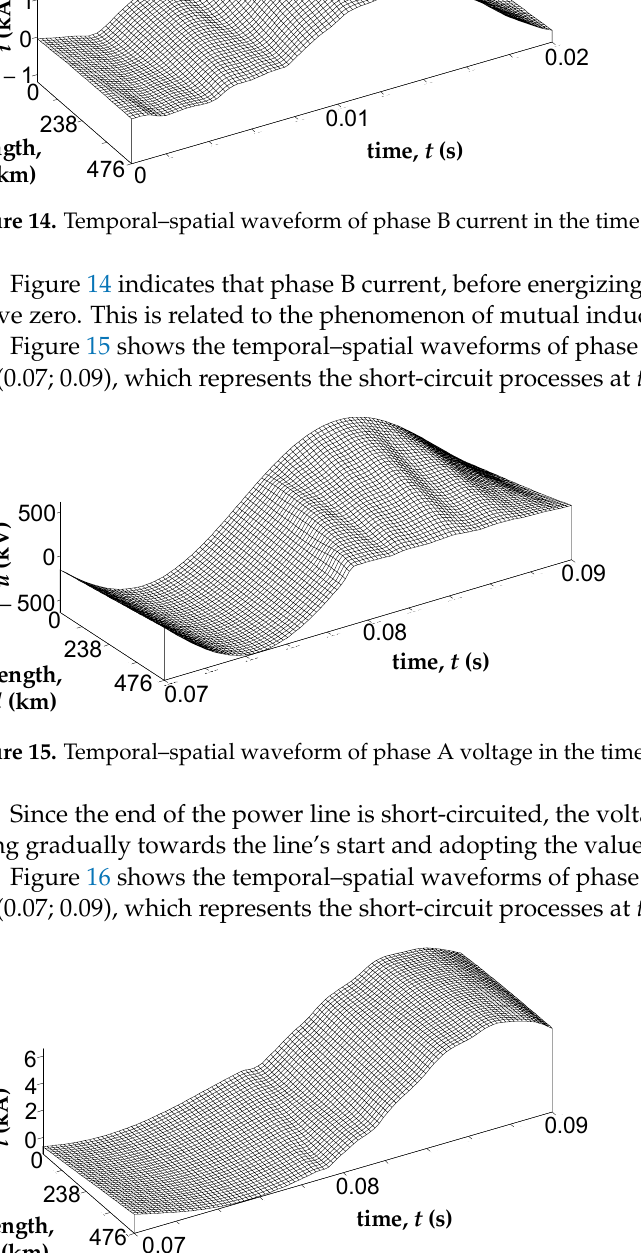
Figure 14. Temporal–spatial waveform of phase B current in the time range t  (0; 0.02) s.